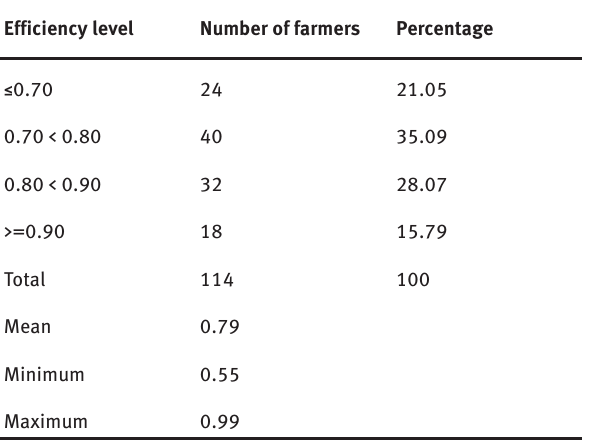
Table 5: Distribution of technical efficiency index score